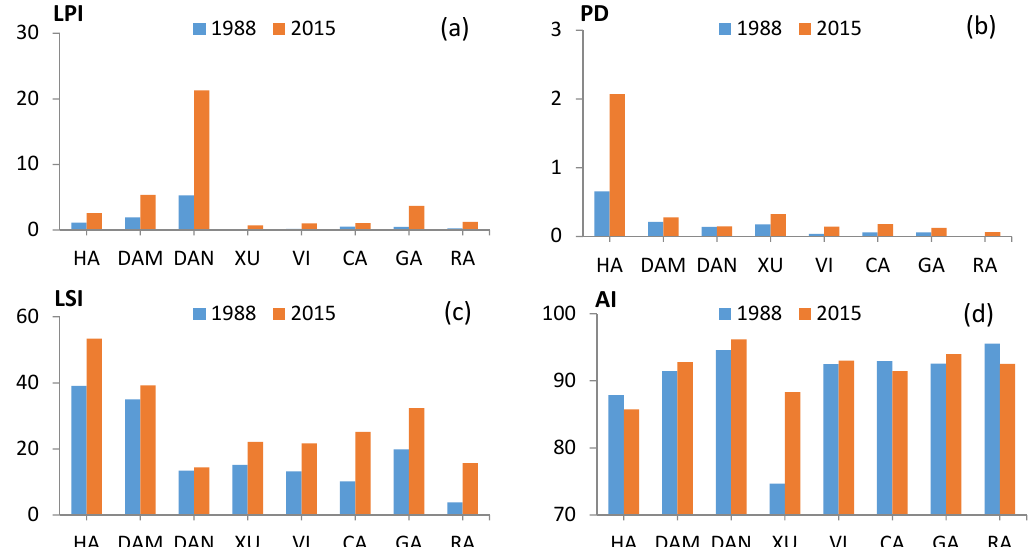
Figure 6. Four landscape indicators of the bays in 1988 and 2015. ( a ) largest patch index (LPI); ( b ) patch density (PD); ( c ) landscape shape index (LSI); ( d ) aggregation index (AI). Note: The abbreviations of